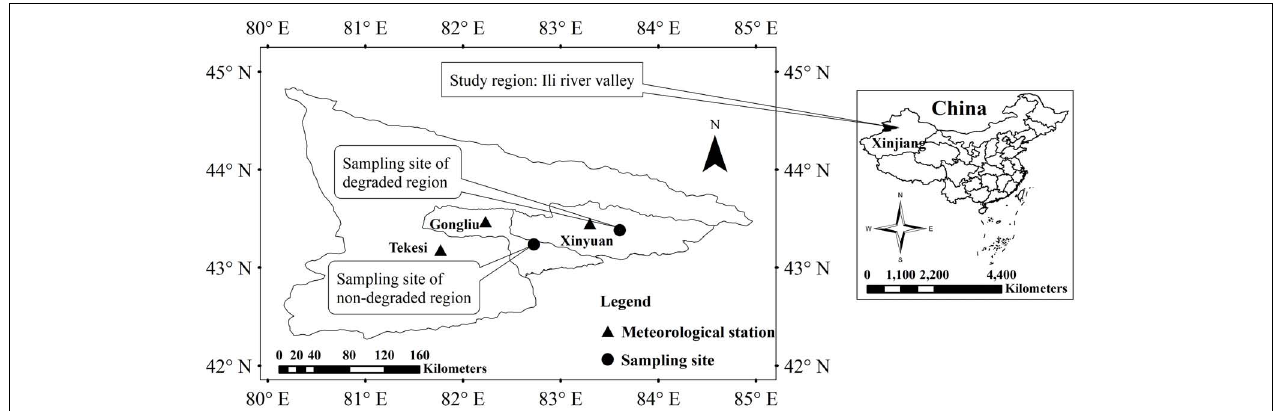
FIGURE 1 | Overview of the study area. The vector map of China was obtained by vectorizing the Chinese map [Approval Number: GS (2016) No. 2893] supervised by the Ministry of Land and Resources of China.